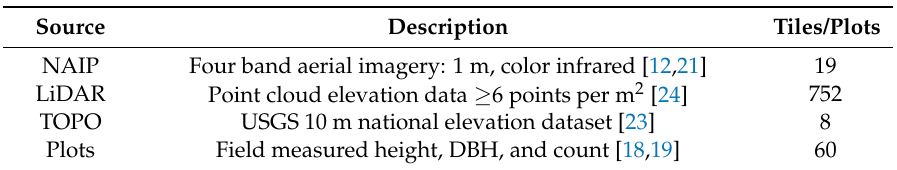
Table 1. Description for baseline